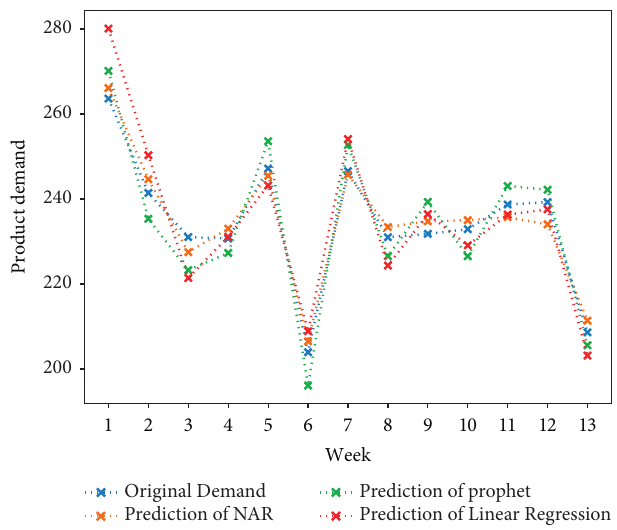
Figure 10: Results of different prediction algorithms.